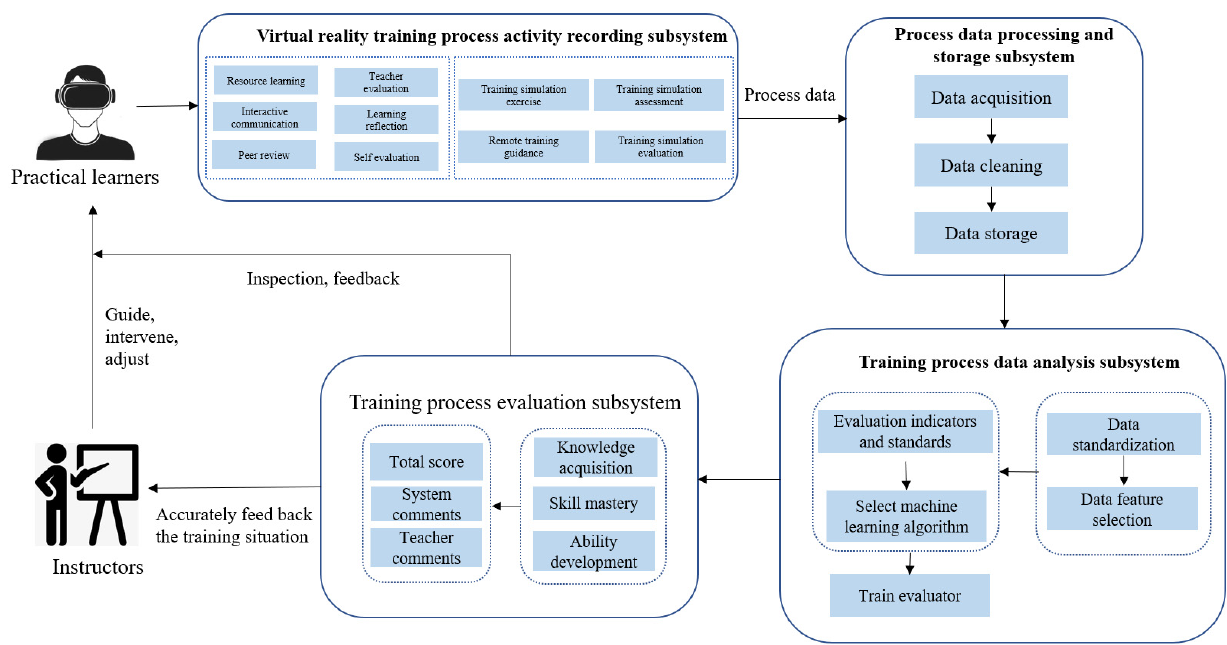
Figure 1. The model of the procedural data evaluation system for vocational skills training in a VR environment.